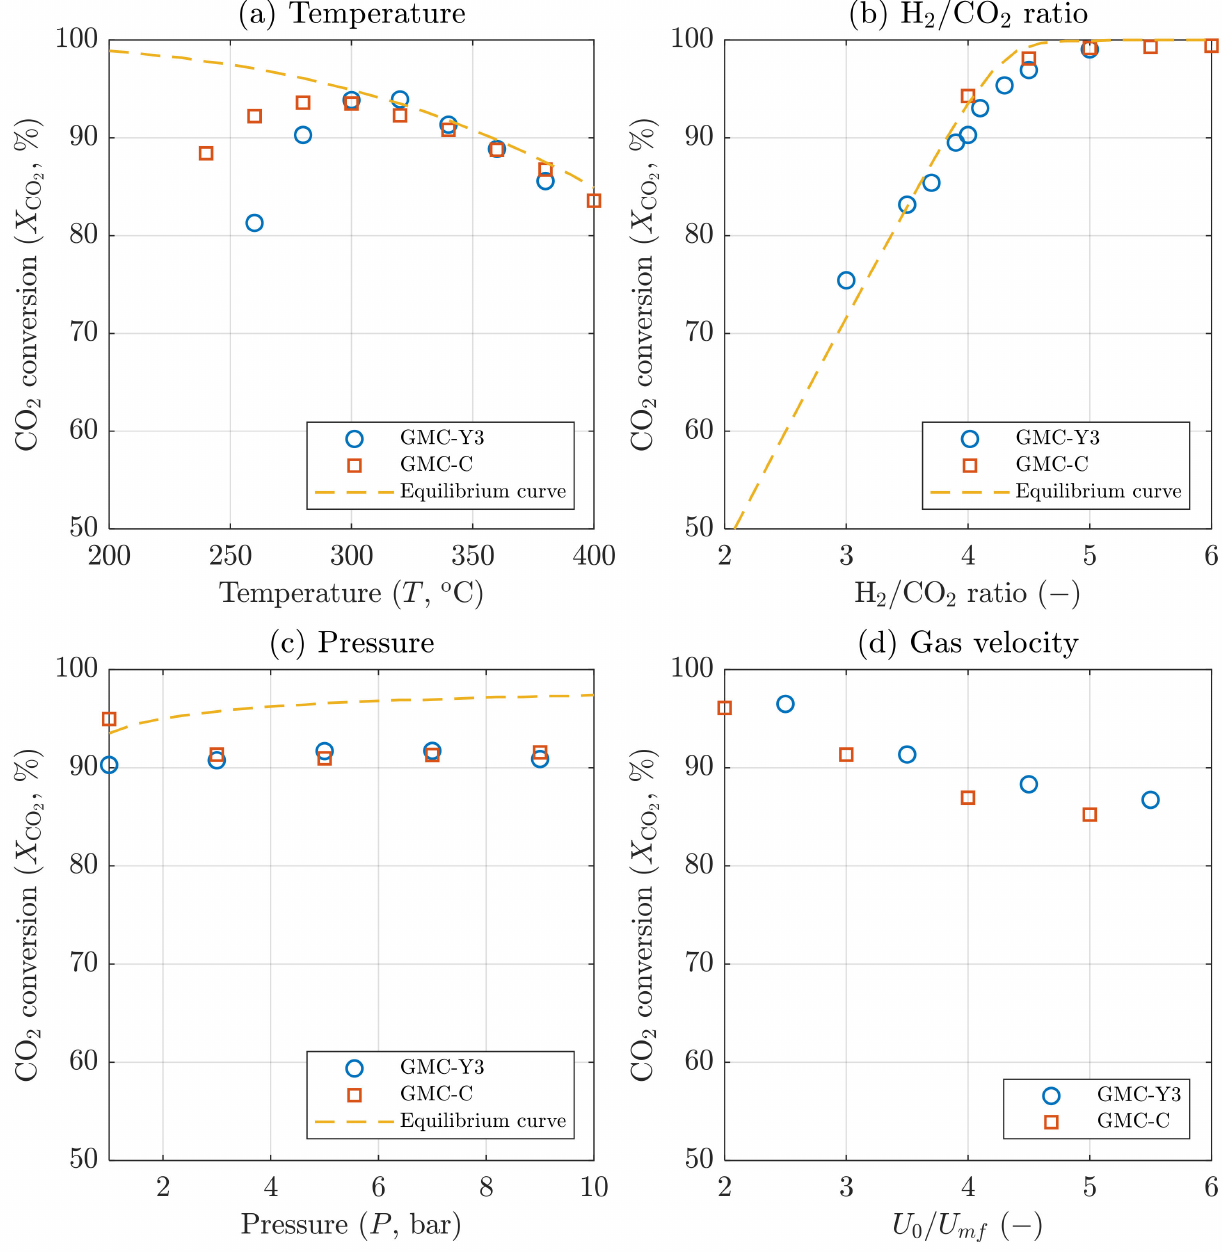
Figure 5. Catalytic activity of GMC-Y3 and GMC-C at the different conditions: ( a ) temperature, ( b ) H 2 /CO 2 ratio, ( c ) pressure, and ( d ) gas